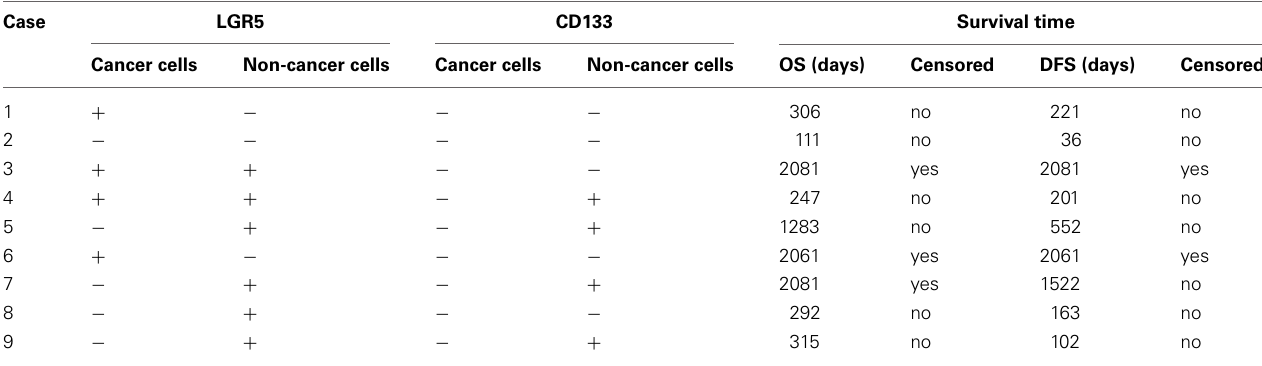
Table 2 | Expression of LGR5 and CD133 in pancreatic tissue and survival time. Case LGR5 CD133 Survival time Cancer cells Non-cancer cells Cancer cells Non-cancer cells